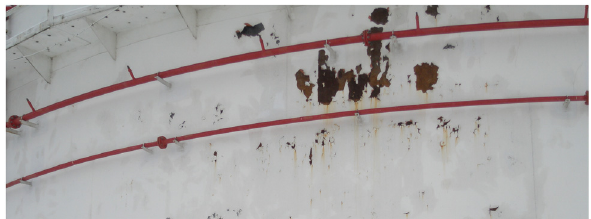
Figure 3: One of the shell zones of tank number 1 with even corro - sion in fl uence, locally identi fi